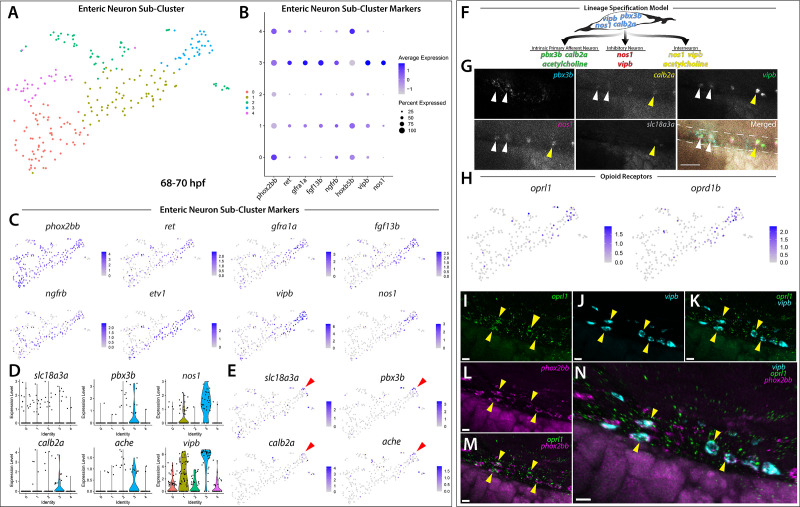
Differentiating enteric neurons captured during key transitional stage of subtype diversification within 68–70 hpf sox10:GFP+ larval cells.(A) tSNE plot reveals five distinct sub-clusters following the subset analysis and re-clustering of Clusters 5 and 12 from the 68–70 hpf data set. (B) Dot plot depicts expression levels of enteric neuron markers across resulting Sub-clusters. Each marker was expressed at low levels in Sub-cluster 1 and were found to be expressed at higher levels within Sub-cluster 3. (C) tSNE feature plots further depict the expression of enteric neuron markers by illustrating the levels and localization of expression within the Sub-cluster architecture. Feature plots supplement dot plot and demonstrate the prominent expression of enteric neuron markers within Sub-cluster 3, which appears to emanate from Sub-cluster 1. (D,E) Violin and feature plots reveal expression levels of acetylcholine-associated and excitatory neuron markers reported to distinguish enteric IPANs. These markers were found in a discrete pocket of cells forming the distal-most region of Sub-cluster 3 (red arrowhead). Violin data points depicted in each Sub-cluster represent single cells expressing each gene shown. (F) Graphical model summarizes expression patterns observed in 68–70 hpf data set and HCR validation. Common enteric neuroblast capable of diverging into subsequent lineages, IPAN, inhibitory neuron, and interneuron through lineage restricted gene expression. pbx3b promotes assumption of IPAN role through loss of nos1 and vipb and begins expressing calb2a, ache, and slc18a3a. (G) Whole mount HCR analysis reveals co-expression of IPAN marker genes, pbx3b and calb2a, and inhibitory neurochemical marker genes, vipb and nos1 (white arrowheads), within the foregut (dashed white line) at 68 hpf. Vesicular acetylcholine transferase, slc18a3a, was not observed in tandem with pbx3b but was co-expressed with calb2a, vipb, and nos1 (yellow arrowheads). Scale bar: 50 μM. (H) Feature plots reveal expression of opioid receptor genes, oprl1 and oprd1b, within the differentiated enteric neuron Sub-cluster 3. (I–N) Whole mount HCR analysis validates expression of oprl1 in combination with vipb and phox2bb (yellow arrowheads) in enteric neurons localized to the foregut region of a 68 hpf embryo. Scale bar: 10 μM.Figure 5—source data 1.List of marker genes per Sub-cluster, following subset and re-clustering of enteric Clusters 5 and 12 at 68–70 hpf.Table reporting the Seurat output for genes for each Sub-cluster (0–4), including p-values (<0.01), average log-fold change (.25), adjusted p-values (1.0), pct.1 summarizing proportion of cells expressing the individual gene in the Sub-cluster, pct.2 showing the proportion of cells expressing the individual gene in all other Sub-clusters in the sub-data set.Figure 5—source data 2.List of enriched pathways within enteric neuron Sub-cluster 3 and genes present in specific opioid proenkephalin pathway identified following PANTHER Overrepresentation Test.Source Data table contains two sheets. Enriched Gene Pathways sheet lists the enriched pathways identified following the use of the statistical test, Fisher’s exact test that compares the number of genes in a given pathway within the reference Danio rerio list to the number of genes in a given pathway within the enteric neuron Sub-cluster 3 list. This analysis produced 43 statistically overrepresented pathways. Column B: Number of genes within the given pathway present with Danio rerio reference list of 25888 genes. Column C: Number of genes within the given pathway present within Sub-cluster 3 gene list. Column D: Number of pathway genes expected to be present within the Sub-cluster 3 gene list based on the percentage of pathway genes present in the Danio rerio reference list. Column E: Denotes that more pathway genes were present in Sub-cluster 3 gene list than expected. Column F: Fold enrichment of Sub-cluster 3 pathway genes comparative to reference list. Column G: p-values calculated following Fisher’s exact test comparing expected number of pathway genes to number of genes pathway genes in Sub-cluster 3. Column H: p-value following Benjamini-Hochberg false discovery rate (FDR) correction. Opioid proenkephalin pathway sheet lists genes associated with this pathway that are present within the enteric neuron Sub-cluster 3 gene list, notably, opioid receptor oprd1b.